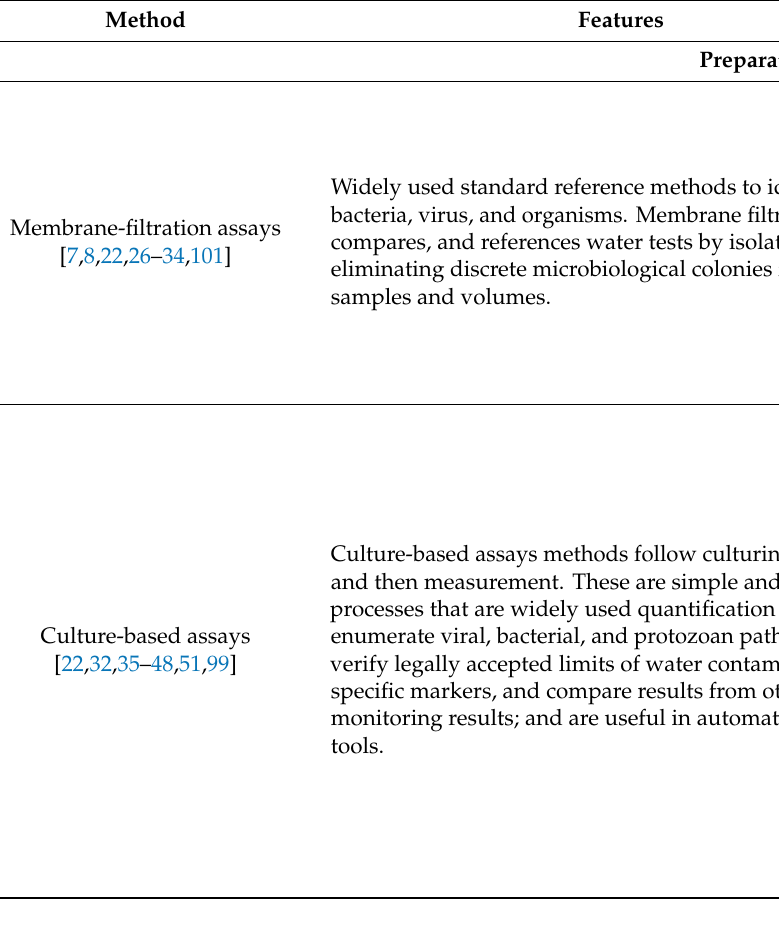
Table A1. Existing water quality preparation-type and measurement-type detection applications for E. coli and